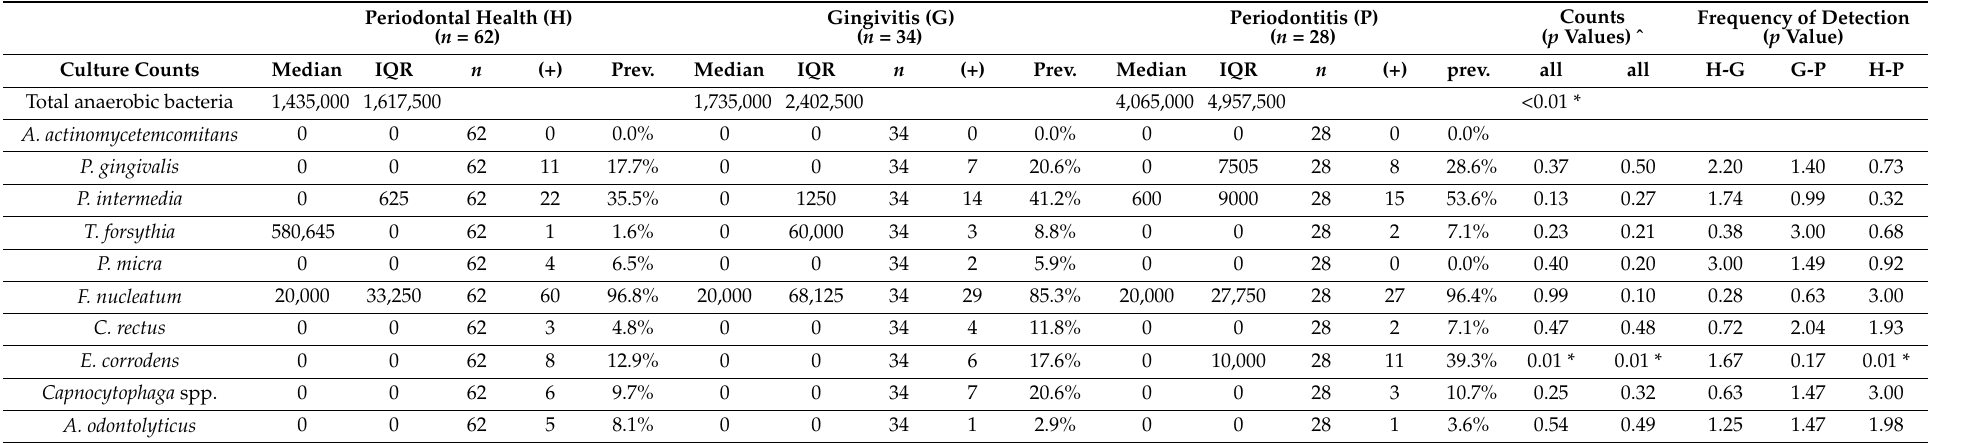
Table 4. Microbiological findings (culture), with counts (colony forming units per mL) expressed as medians and interquartile ranks (IQR) and frequencies of detection expressed as percentage, for each study group, with the appropriate